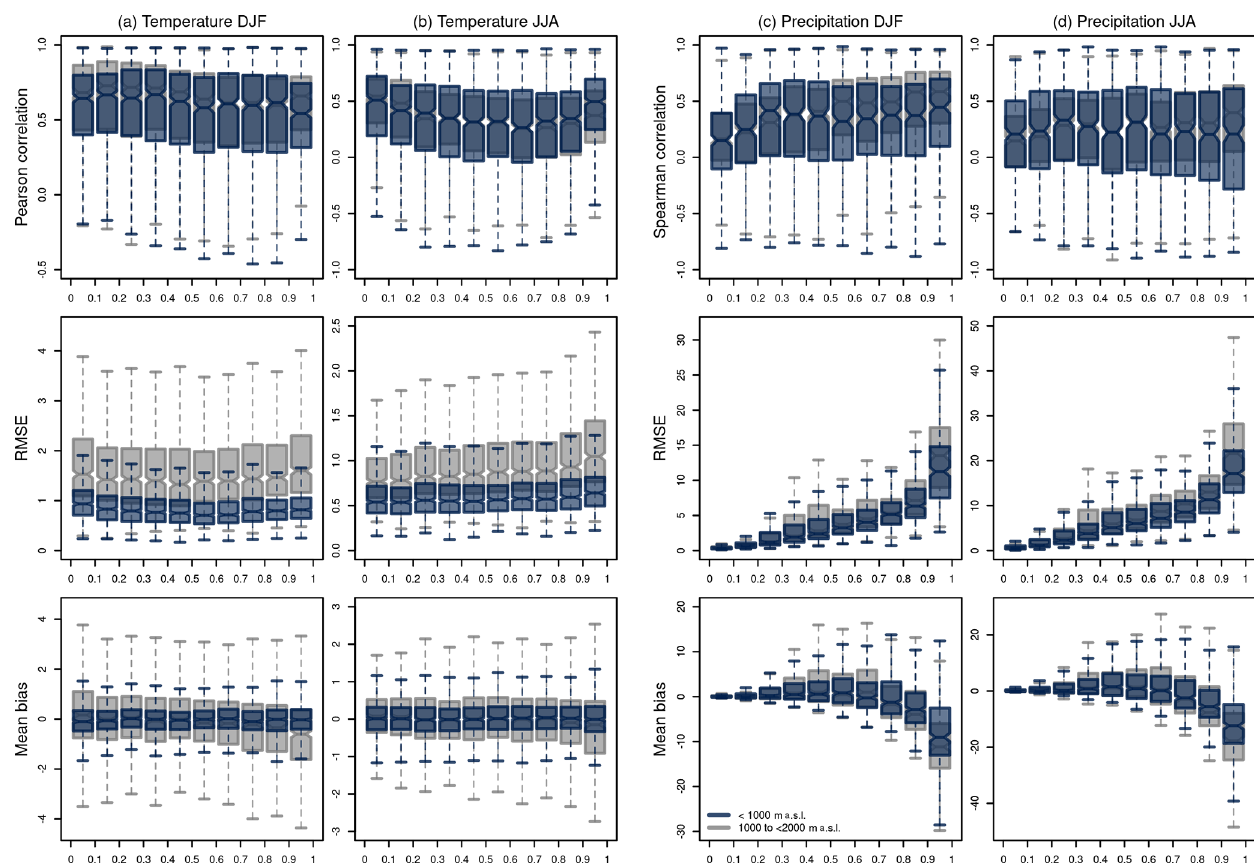
Figure 4. Spatial evaluation of the reconstruction ordered according to the deciles of the area mean between 7.4 and 9.1 ◦ E and 46.5 to 47.3 ◦ N for the original data set. (a–b) DJF and JJA temperature evaluation with removed seasonality for Pearson correlation, RMSE, and mean bias. (c–d) DJF and JJA precipitation evaluation for Spearman correlation, RMSE, and mean bias. Blue values show all grid cells below 1000ma.s.l.; grey values show grid cells above 1000ma.s.l. The boxes range from the first to the third quartile, and whiskers extend to 1.5 times the interquartile range outside the